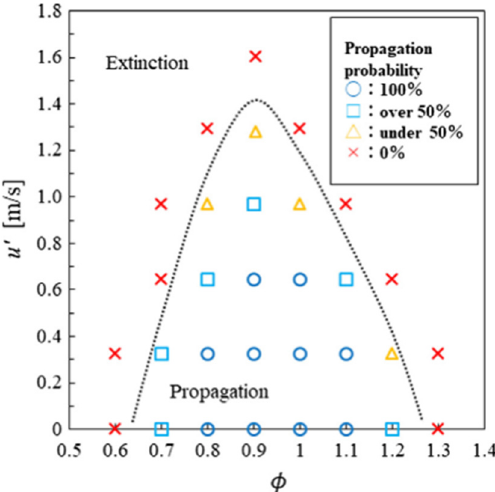
Figure 8. Flame propagation probability map of the NH 3 -air flames at the turbulence intensity. Courtesy of Elsevier [61].